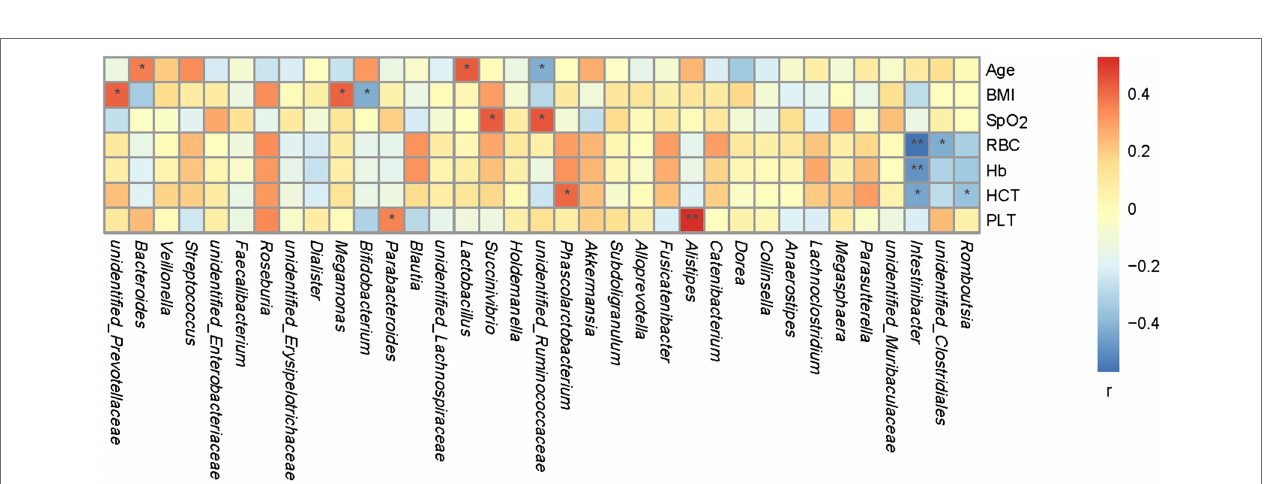
FIGURE 3 | Bacterial taxa that differed significantly between native Tibetans and Han immigrants were identified with: (A) a MetaStats analysis, in which the abundances of the 35 most significantly different taxa in the two groups are shown in a heatmap, p < 0.05, q < 0.05; (B) a linear discriminant analysis (LDA) effect size (LEfSe), using the default parameters. A histogram of the LDA scores computed for the bacterial taxa that differed in abundances in the two groups is